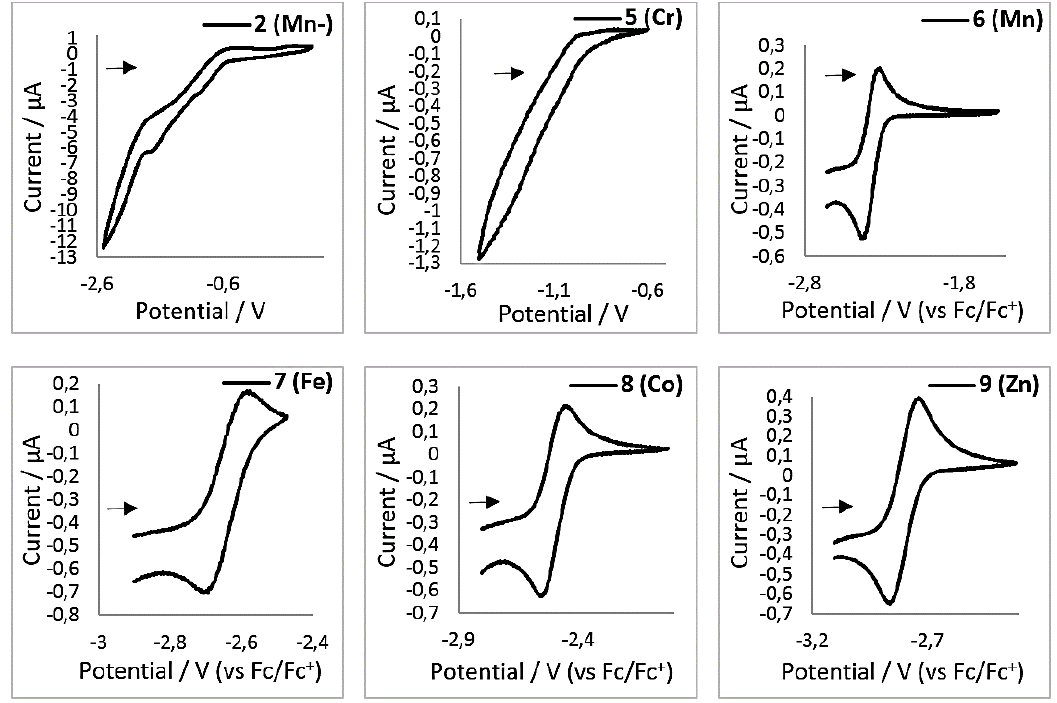
Figure 8. Cyclic voltammograms for complexes 2 , 5 – 9 in THF (1 mM, 500 mV / s, 0.1 M [NBu 4 ][PF 6 ]).